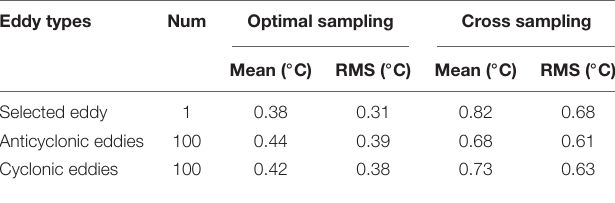
TABLE 2 | Statistical results of the residual errors in simulation